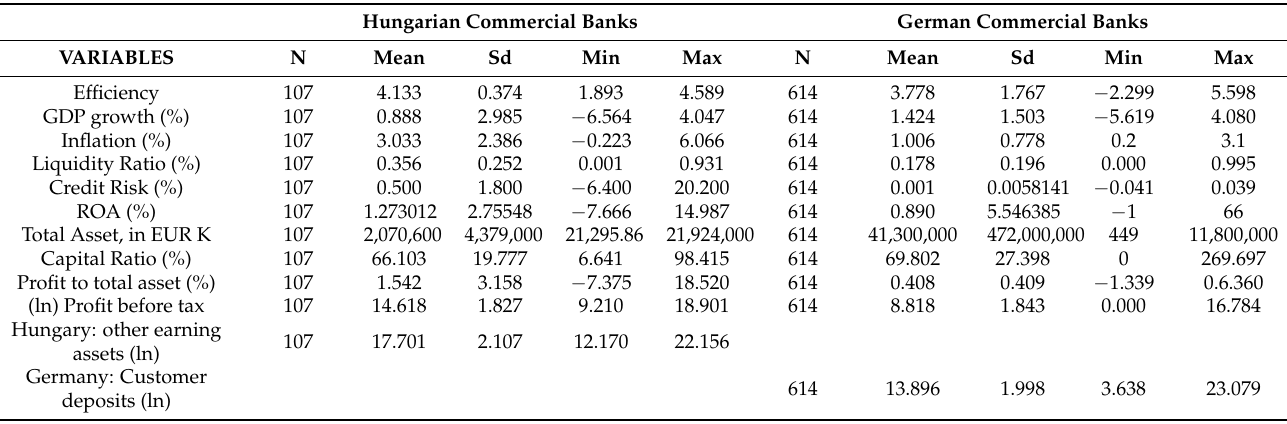
Table 2. Data presenting summary statistics of unconsolidated financial statements of Hungarian and German commercial banks for the entire period of 2005–2015.